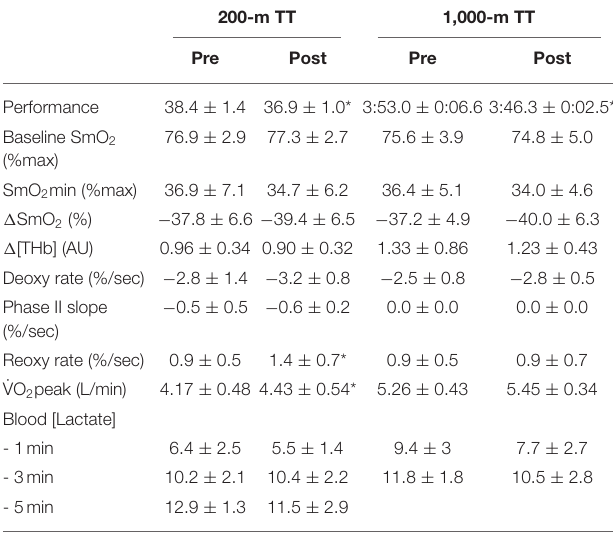
TABLE 2 | Performance and physiological parameters recorded during TT before and after the training